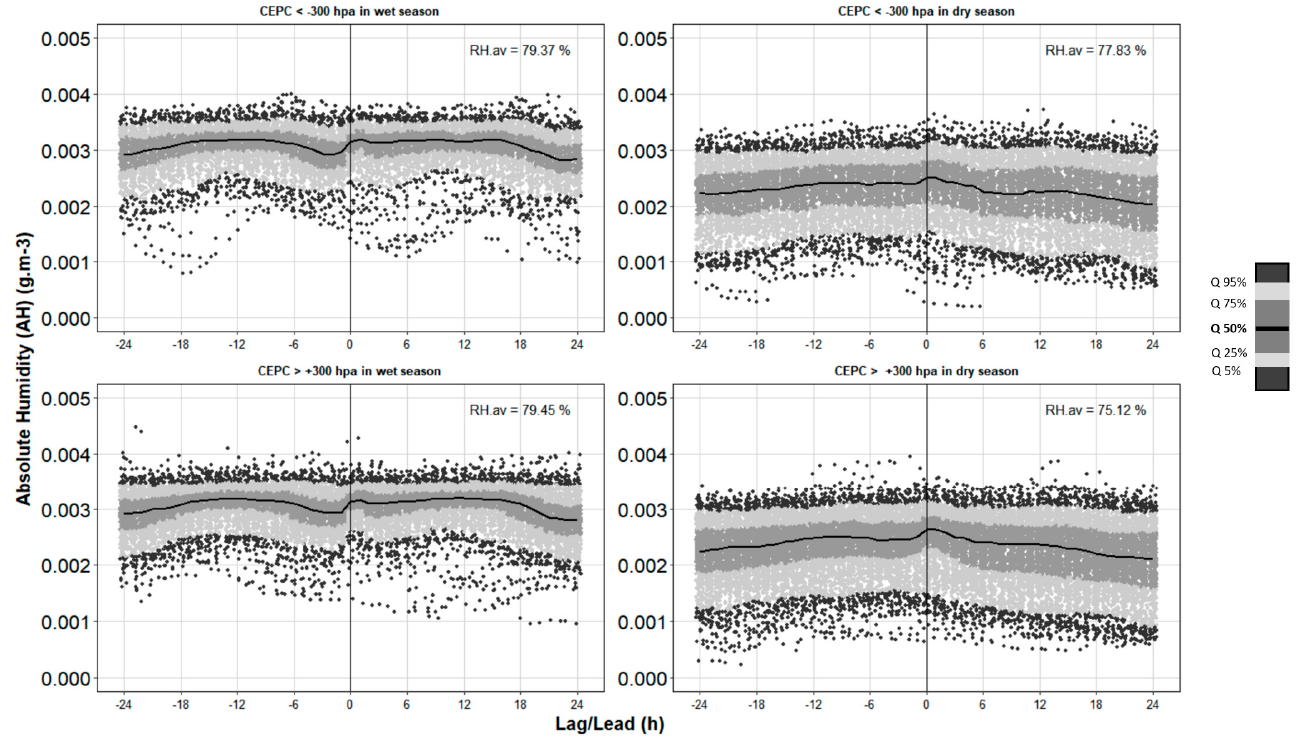
Figure 6. Quantile ranges of absolute humidity (AH) in extreme pressure change events (PCEs) responding to precipitation. The solid center line at 0 h indicates the start of precipitation. Seasons (dry and wet) and cumulative event pressure change (CEPC) are used to categorize the analysis